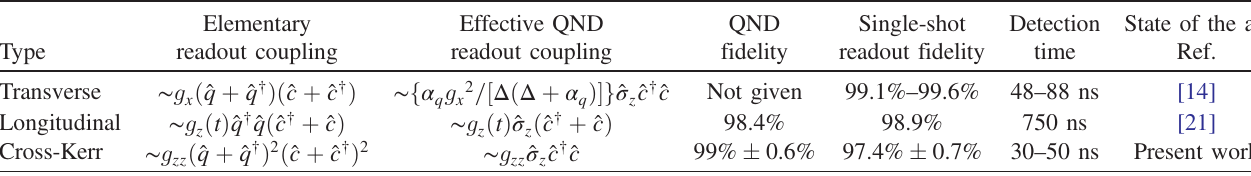
TABLE I. State-of-the-art parameters for three different coupling types between a harmonic readout mode and a superconducting qubit. The second column shows the direct coupling terms between the qubit, described as an anharmonic oscillator with ladder operators ( ˆ q , ˆ q † ), and a harmonic readout mode described by ( ˆ c , ˆ c † ). Column three shows the effective coupling obtained after the rotating wave approximation (RWA), and two-level system approximation for all couplings plus the dispersive approximation in the case of the transverse coupling. Note that the present experimental work implements two nonperturbative cross-Kerr couplings of the type presented here, since two polariton modes ˆ c and ˆ c are used for the readout [see Fig. 1 and Sec. II B for more details]. u l